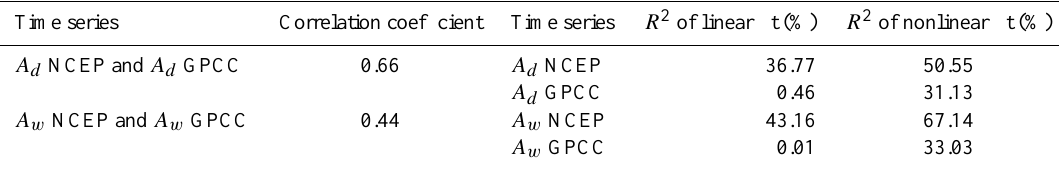
Table 1. Correlation coefficients between A d ( A w ) for the two datasets NCEP/NCAR and GPCC (first two columns), and R 2 of the linear and nonlinear fittings of A d and A w (last three columns).